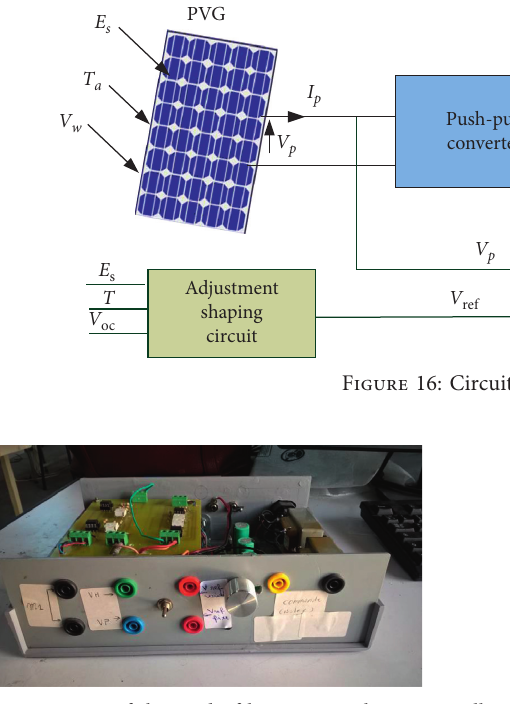
Figure 17: Overview of the card of hysteresis voltage controller.